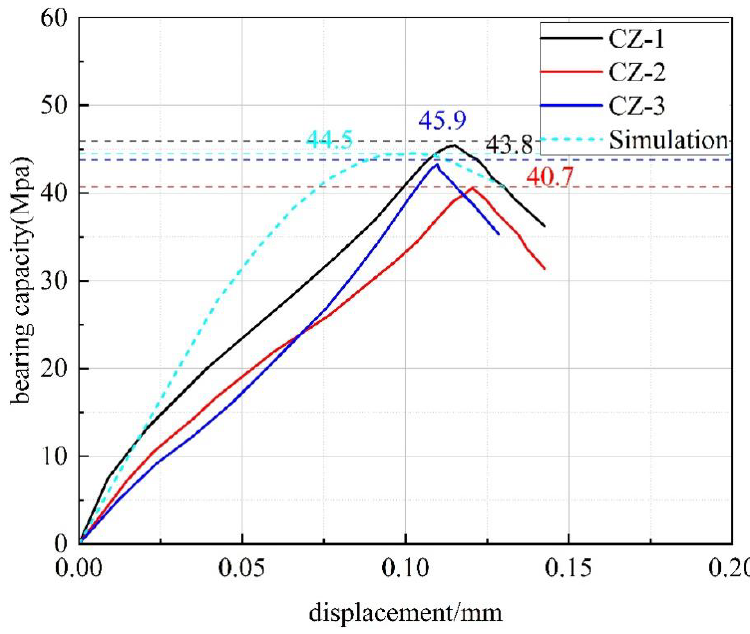
Figure 14. Load–displacement curves associated with the Z-axis compression test and corresponding numerical simulation. Table 20. Comparative analysis of Z-axial compression testing and numerical simulation.